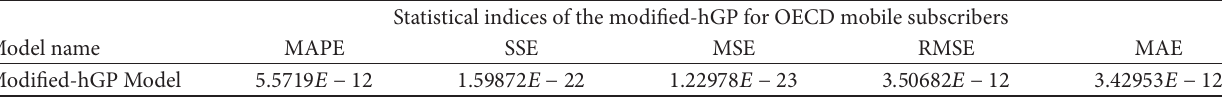
Table 2: Statistical indices in fitting process of the modified-hGP model for the total number of OECD subscribers. Statistical indices of the modified-hGP for OECD mobile subscribers